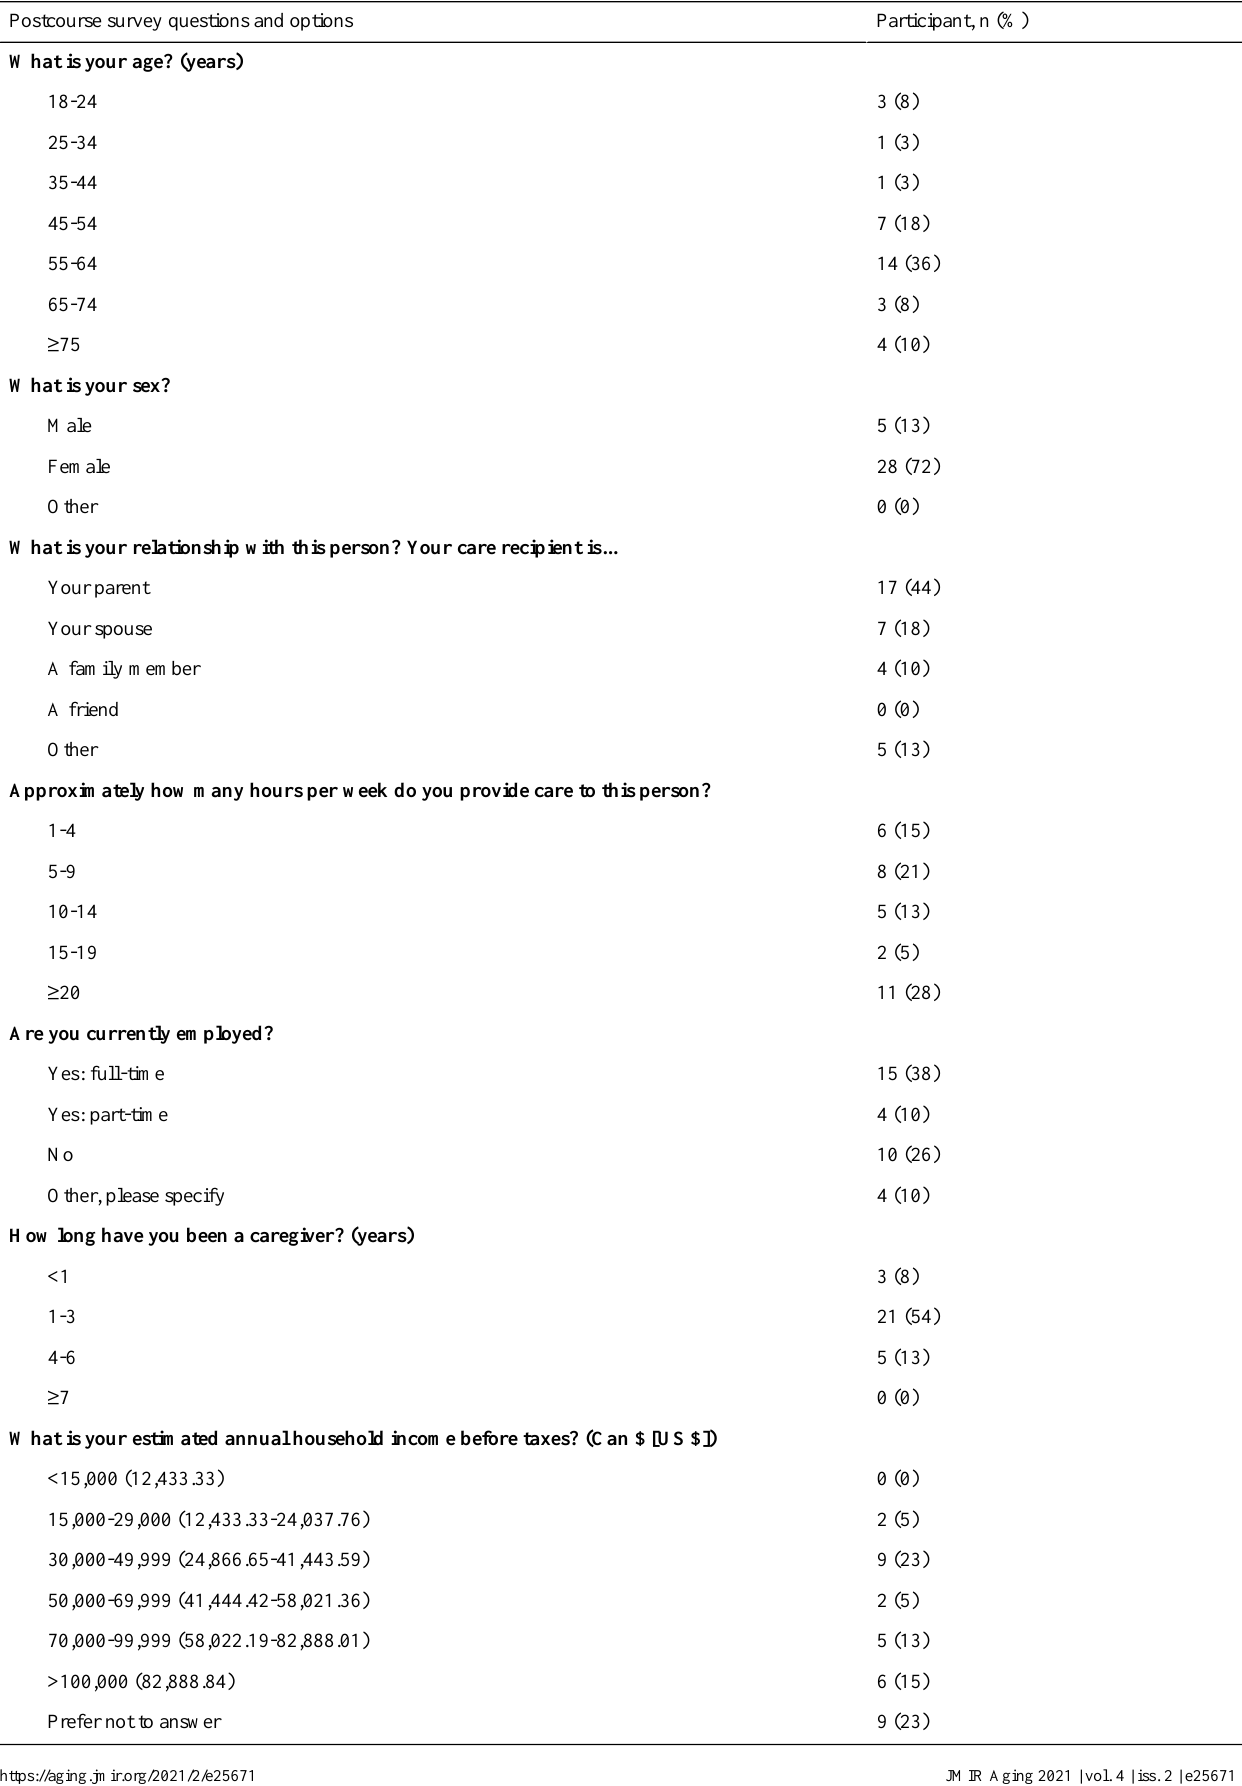
Table 2. Participant information from the postcourse survey (n=39).